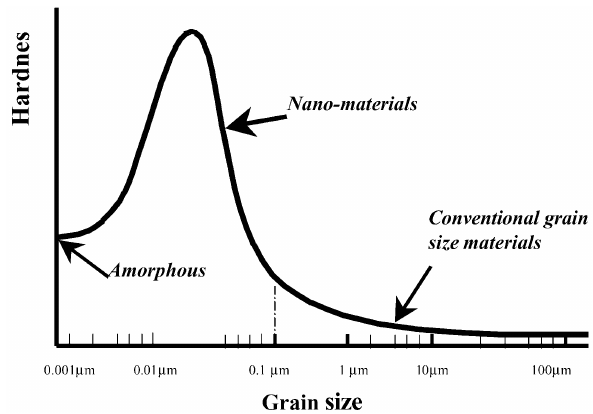
Figure 4: Hardness of material as function of grain size [29]